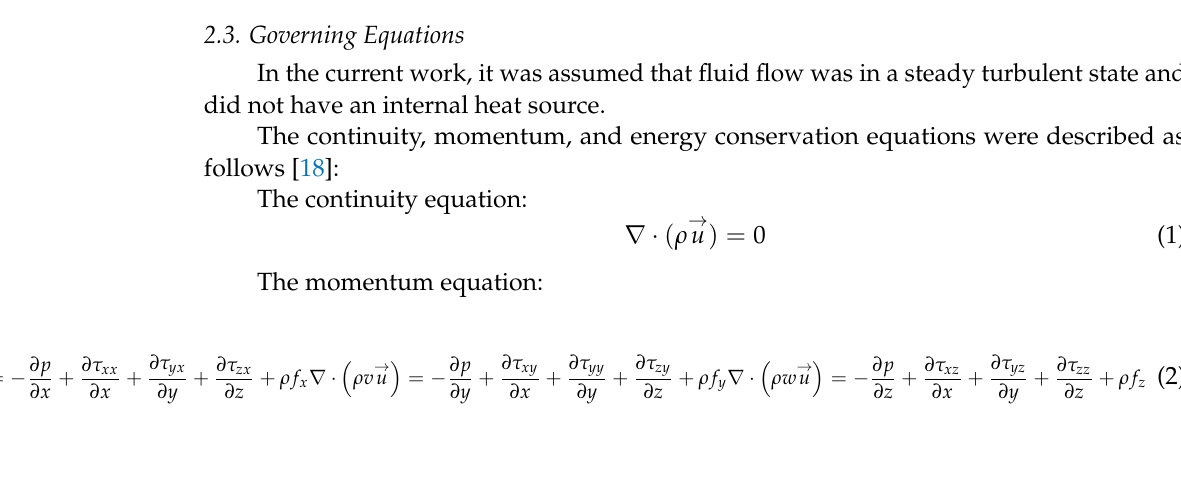
Figure 2. ( a ) Cross yoz section grid; ( b ) xoz section grid.